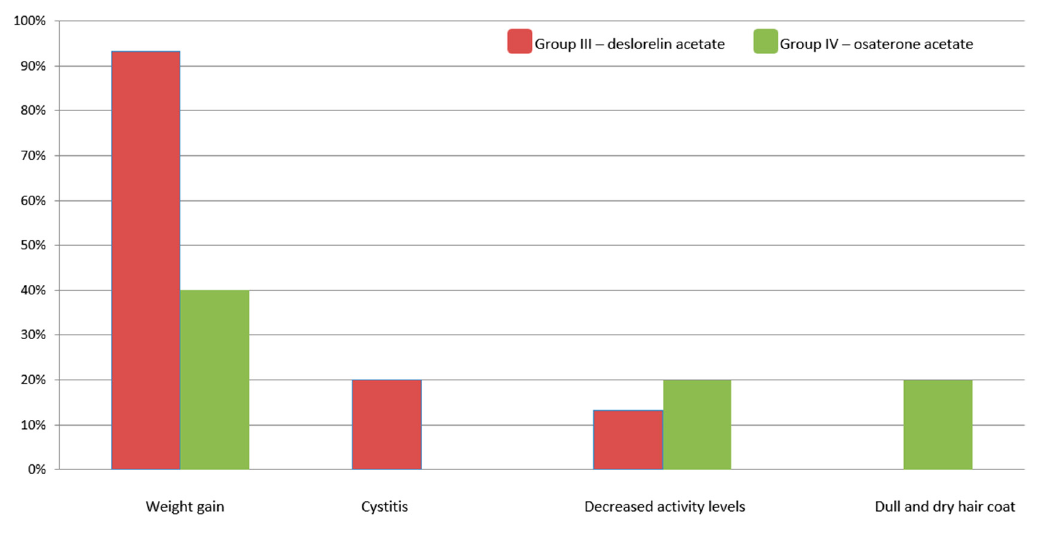
Figure 7. Treatment-related adverse effects observed in the treated Groups III and IV.